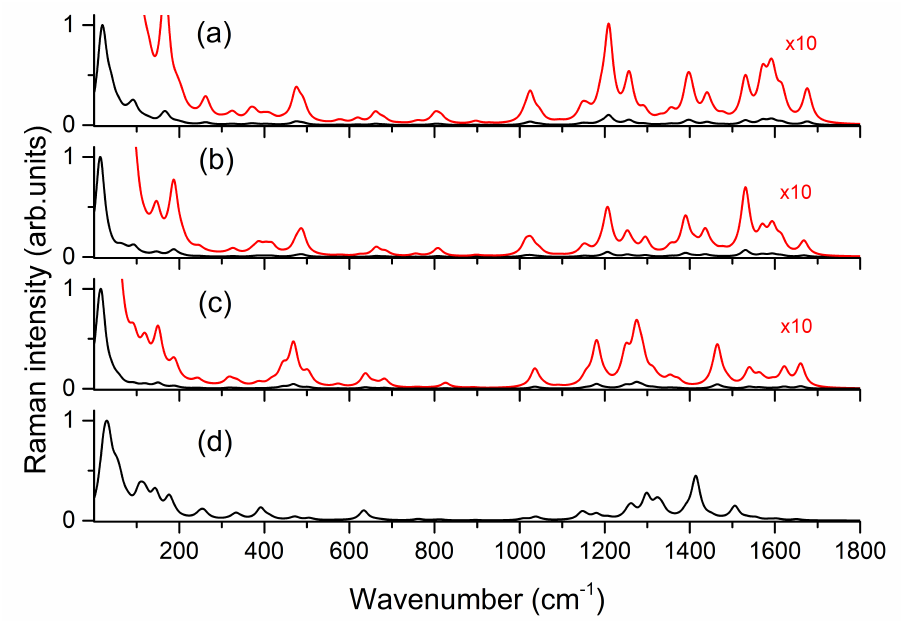
Figure 6. Black lines are the computed SERS spectra of alizarin interacting with silver clusters. The labels refer to models shown in Figure 5. Red lines are the 10 × magnification of the respective black